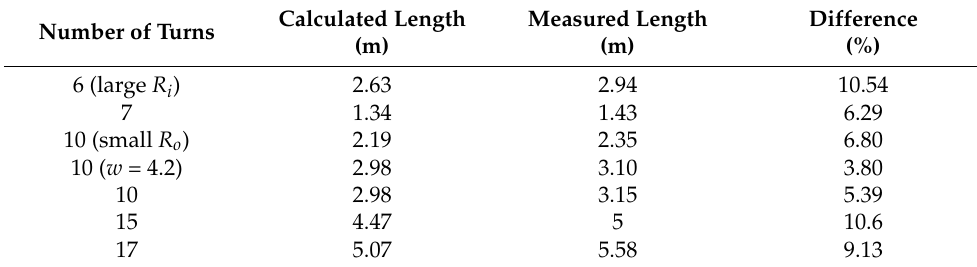
Table 6. Comparison between the calculated and the measured DC resistance of coil.